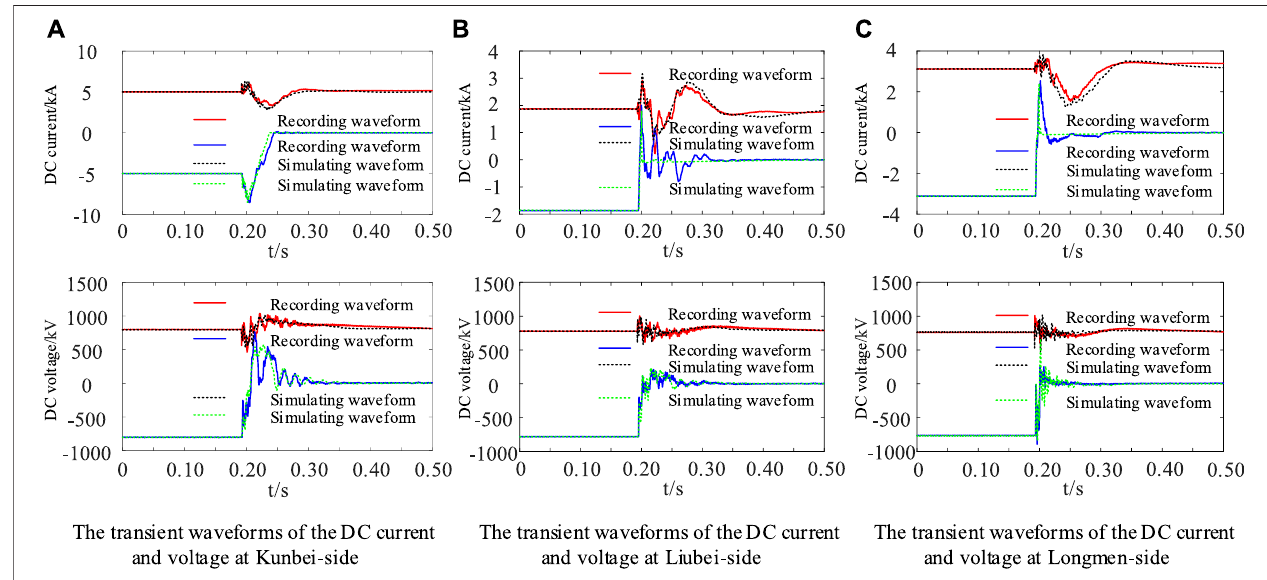
FIGURE 13 | Comparison of transient waveforms of negative electrode midpoint faults in the DC line from Liuzhou to Longmen.